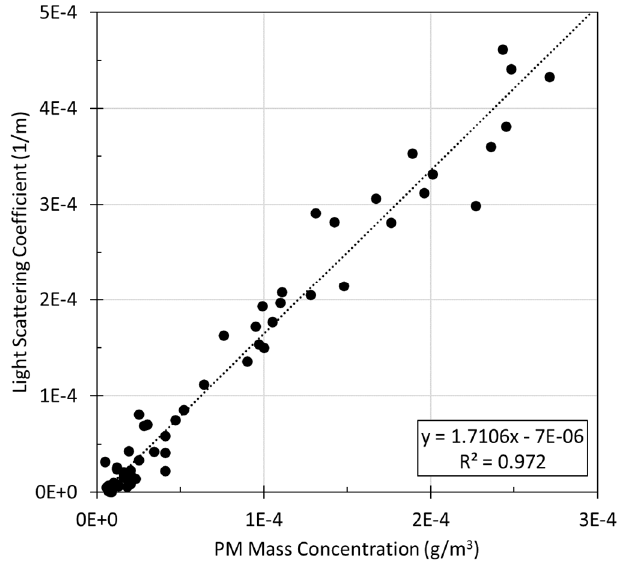
Figure 3. Relationship between light scattering of particles (1/m) and PM mass concentration (g/m 3 ), which gives a slope in m 2 /g.